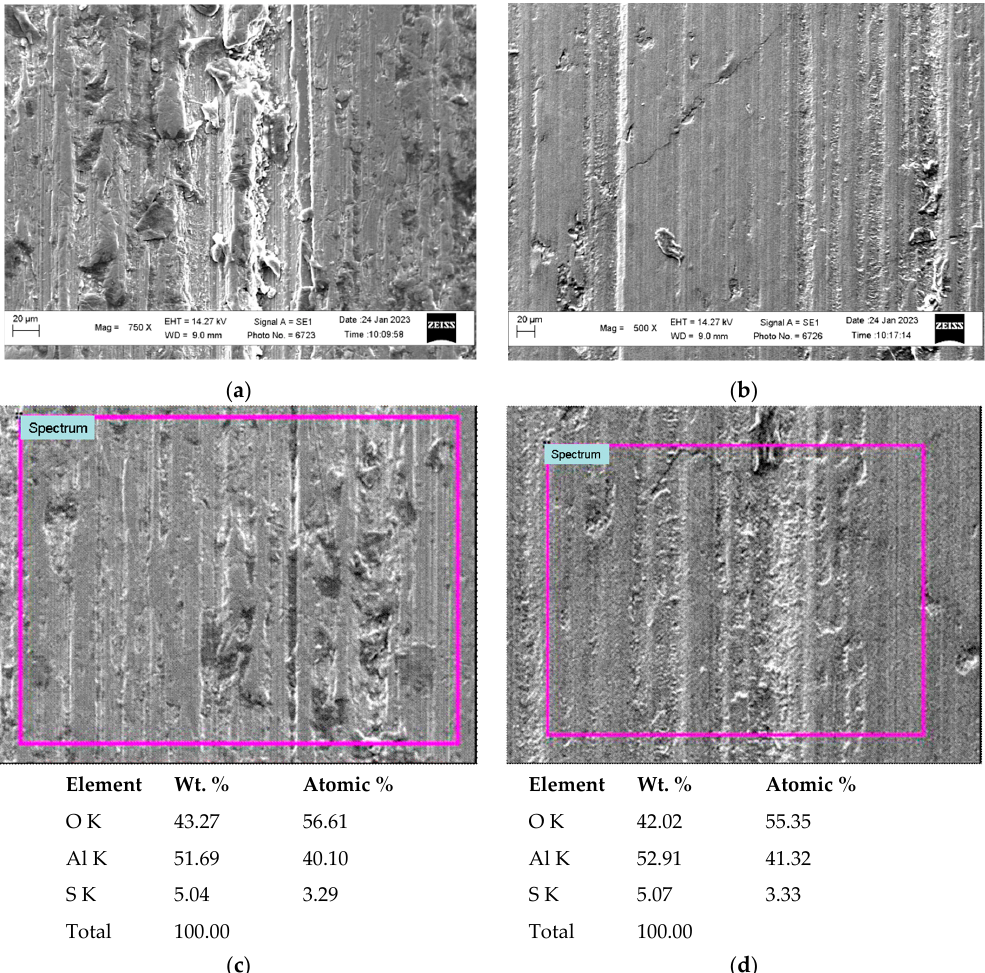
Figure 14. ( a , b ) Characteristic traces of friction during tests for abrasive wear resistance and ( c , d ) results of X-ray microspectral analysis of the area of damaged surfaces of specimens with layers anodized for 1 h, ( a , c ) obtained without heat treatment and ( b , c ) after heat treatment at 300 °C for 1 h. Damage to the surfaces of these specimens occurred through the mechanism of local cutting of the anodized layer by abrasive particles from the counterbody (from a corundum disk), which performed the function of microcutters. However, the distribution over the area and the depth of friction marks in the form of grooves on the surfaces of both specimens differed significantly. So, on the surface of a specimen with a lower hardness, not subjected to heat treatment, the depth and number of grooves left by abrasive particles were greater, and the distance between them was less than on the surface of heat-treated HAL. In addition, in the damaged areas of Figure 14a,c, a large number of zones with signs of local adhesion of friction elements can be observed. All these features of the damaged anodized layer are consistent with the lower surface hardness of this specimen. In the specimen subjected to heat treatment, the contact traces of corundum particles with the anodized surface were wider and less deep than in the specimen without heat treatment. As shown in Figure 14b,d, the traces of contact of corundum particles with an anodized surface on the specimen subjected to heat treatment were wider and less deep than in the specimen without heat treatment. At the same time,